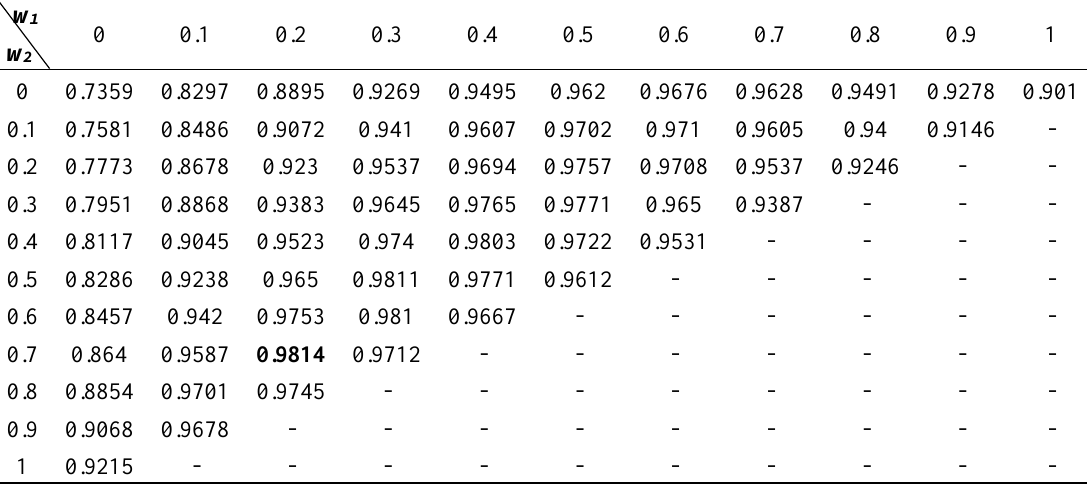
Table 5. Classification accuracy (%) versus the values of University of Pavia dataset with 60 training samples per